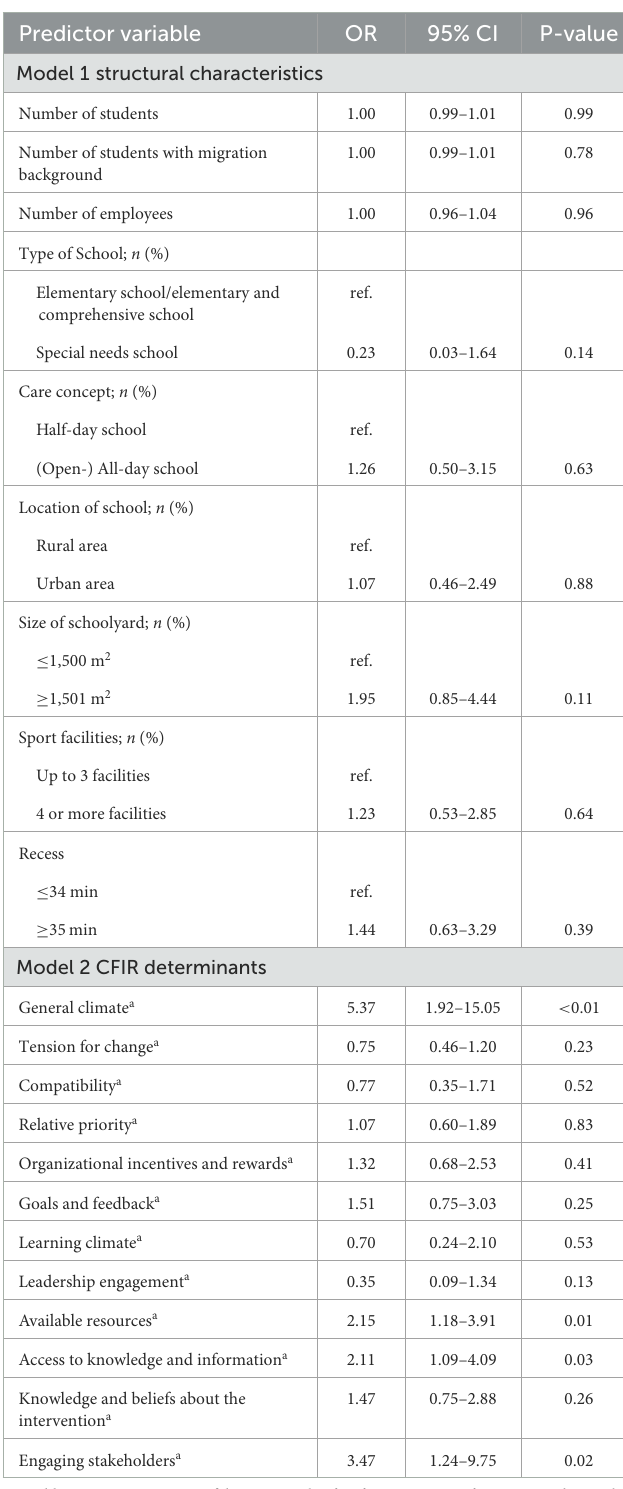
TABLE 4 Multiple logistic regressions: Model 1 and 2 for school structural characteristics and CFIR determinants as predictors of policy adoption ( n =